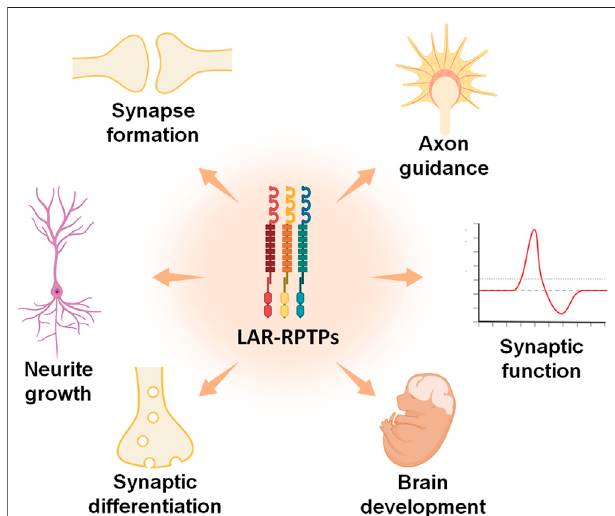
FIGURE 6 | LAR-RPTPs participate in several neural functions. All three LAR-RPTPs are implicated in various functions involved in the biology of neurons,suchasneuriteandaxongrowth,axonguidance,synapticformation and differentiation, synaptic functions, and brain